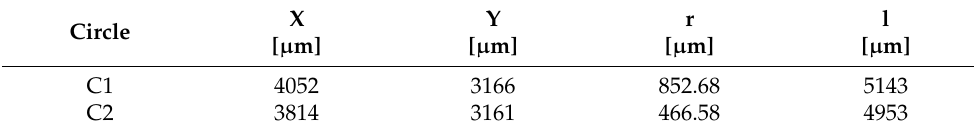
Figure 5. Measuring the curvature radius of the rectangular microchannels. Table 1. Rectangular microchannels measured curvature radii. Table 1. Rectangular microchannels measured curvature radii.